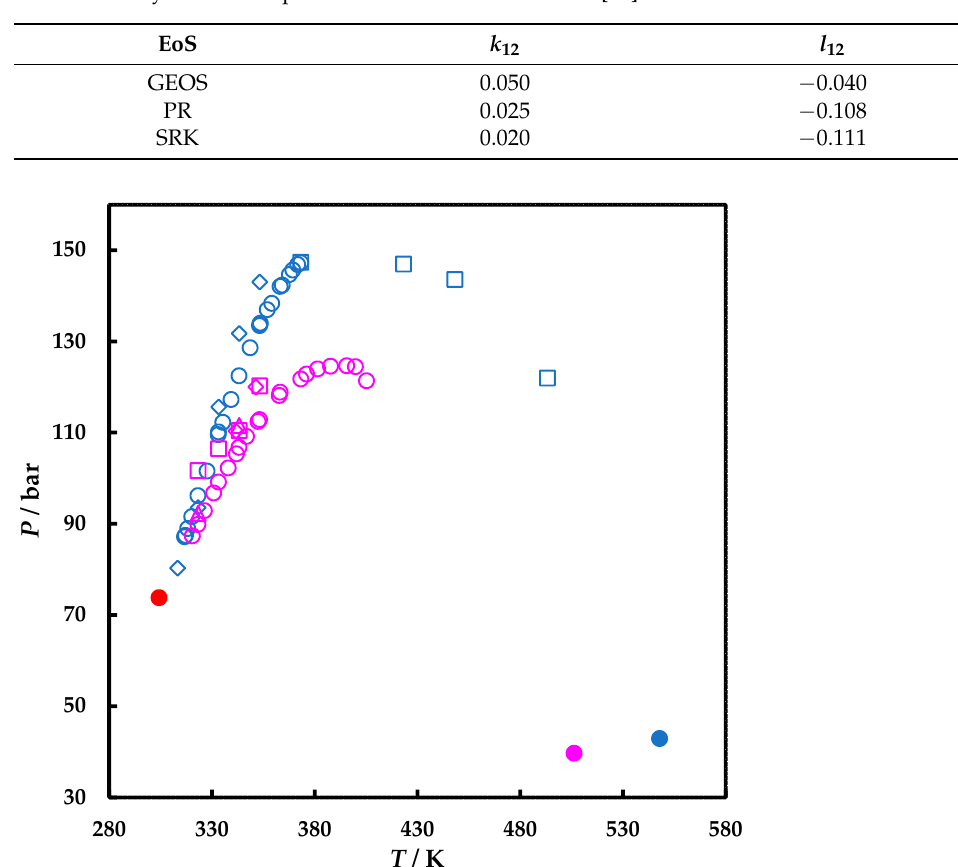
Table 6. Binary interaction parameters used in calculations [37].